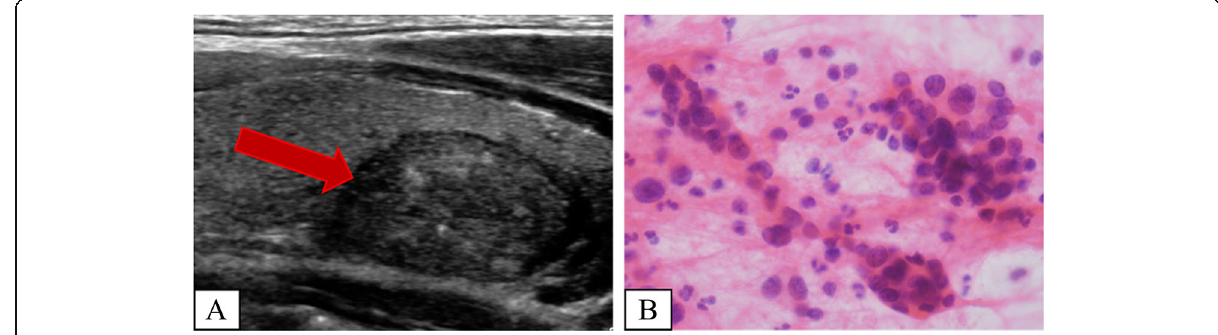
Fig. 1 Ultrasonographic and cytologic features of the thyroid mass. a Ultrasonography reveals a relatively well-circumscribed thyroid mass on the right lobe (arrow). b Some follicular cells showing nuclear enlargement and pale chromatin pattern in cytologic evaluation of FNA specimen (H&E stain; original magnification, ×